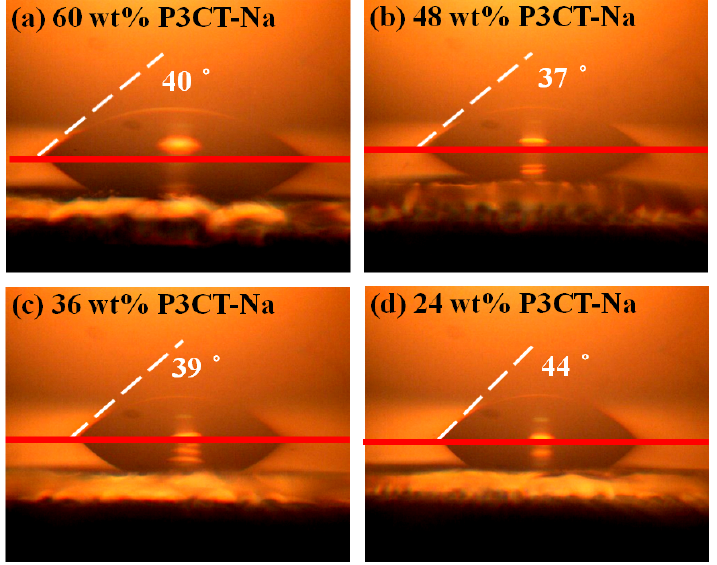
Figure 4. The water-droplet contact angle images: ( a ) 60 wt% P3CT-Na/ITO/glass; ( b ) 48 wt% P3CT-Na/ITO/glass; ( c ) 36 wt% P3CT-Na/ITO/glass; ( d ) 24 wt% P3CT-Na/ITO/glass.